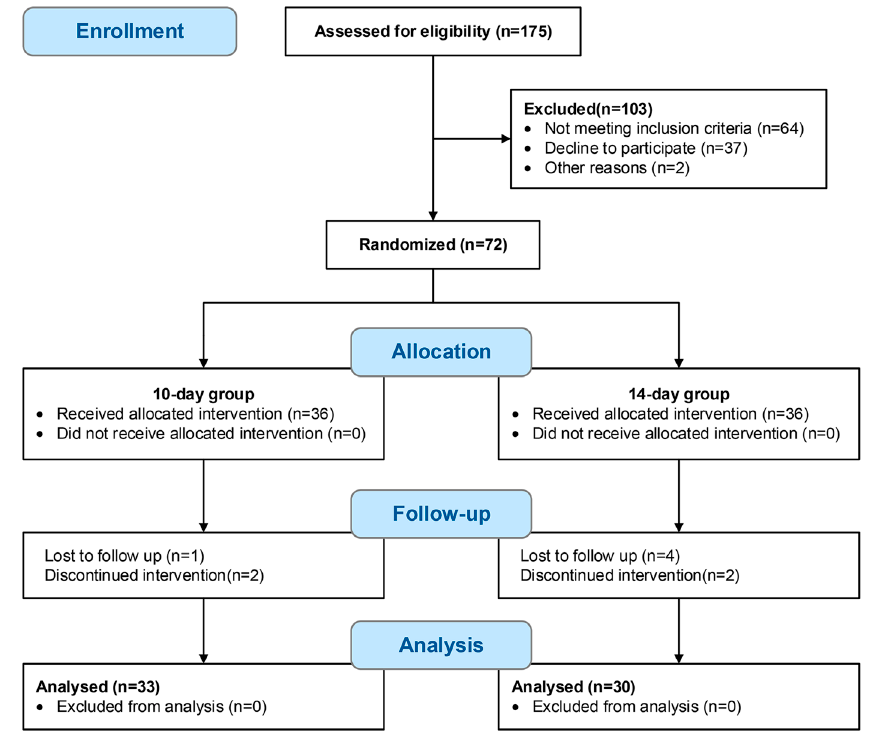
Figure 1. CONSORT flow chart showing subjects flow during the